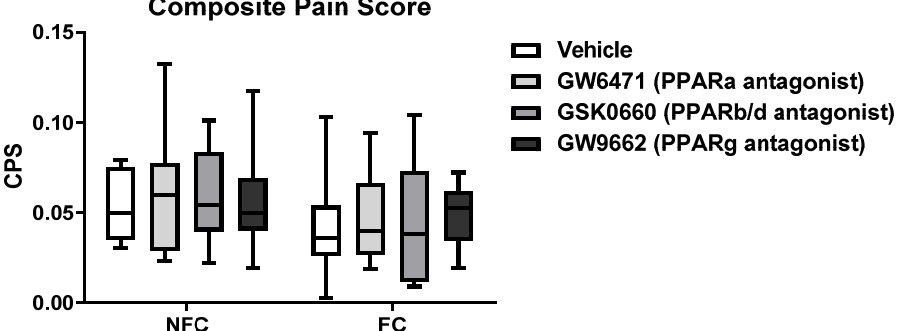
Figure 8. Effects of intra-BLA administration of selective PPAR α , PPAR β / δ , and PPAR γ antagonists on the composite pain score in non-fear conditioned (NFC) and fear conditioned (FC) rats that received an intraplantar injection of saline. Composite pain score was calculated as (pain 1 + 2 × [pain 2])/total duration of analysis period (see for further information in the Material and Methods). Kruskal–Wallis showed no significant difference between groups [ χ 2 (7) = 4.241, p > 0.05]. Data are expressed as median with interquartile range and min/max ( n = 8–10 rats per group).